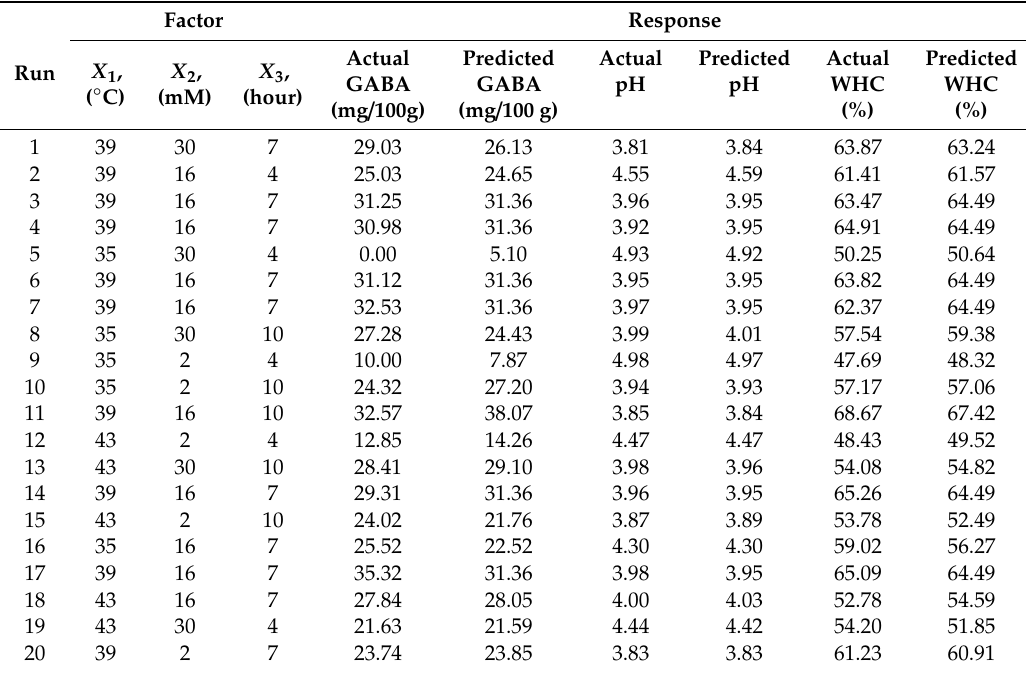
Table 1. Central composite design with actual experimental and predicted response values for yogurt fermented by S + UPMC90 + UPMC91 LAB